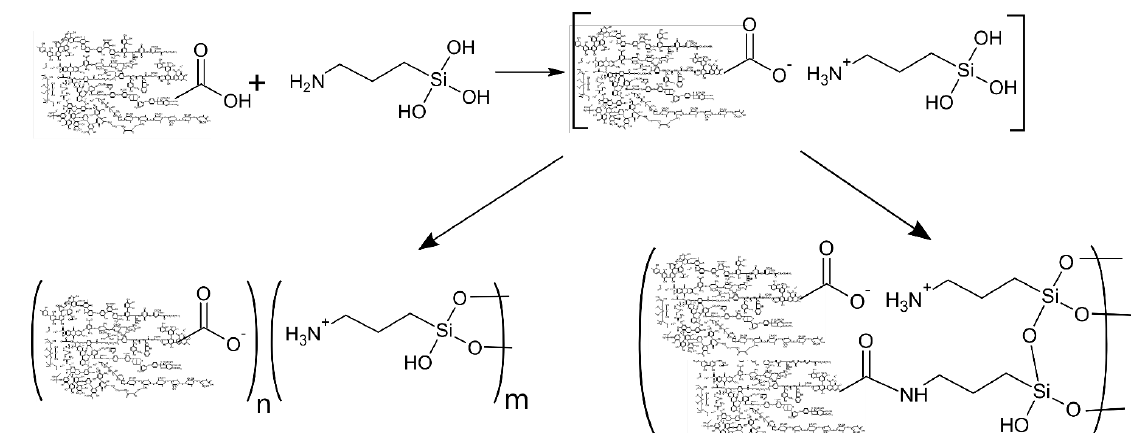
Figure 1. The proposed scheme of interaction of humic substances (HS) with 3-aminopropyltriethoxysilane (APTES) with the formation of HS-silane polyelectrolyte complexes.